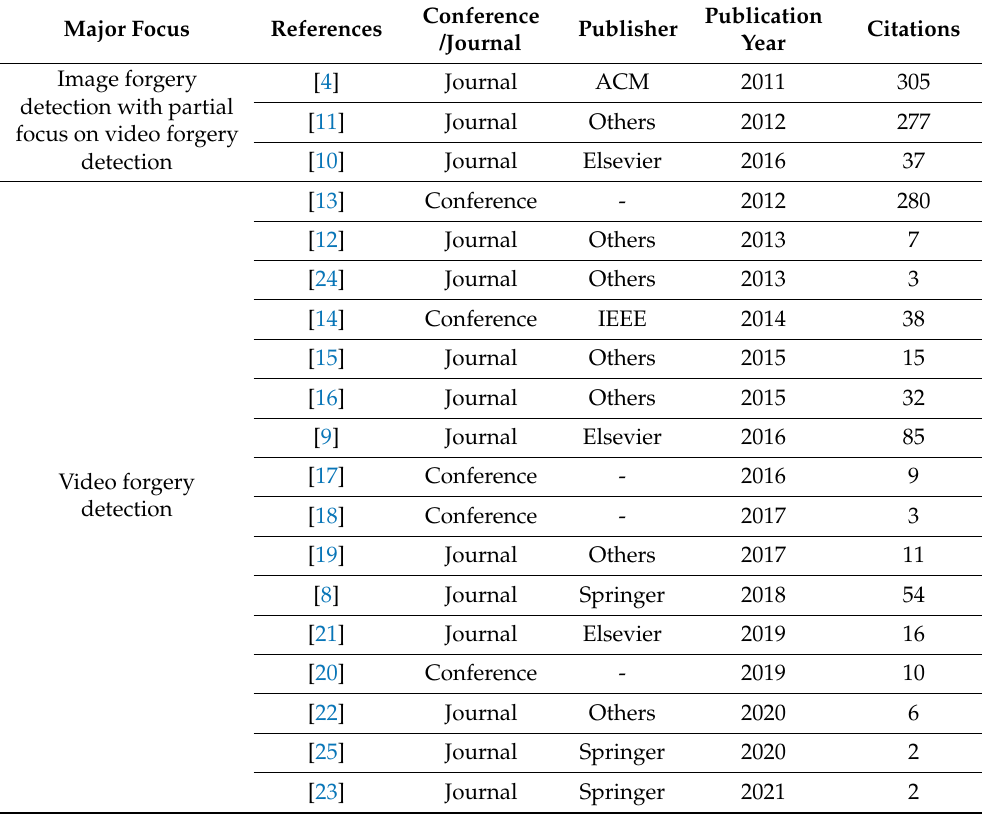
Table 1. Summary of survey papers on video forgery detection. Major